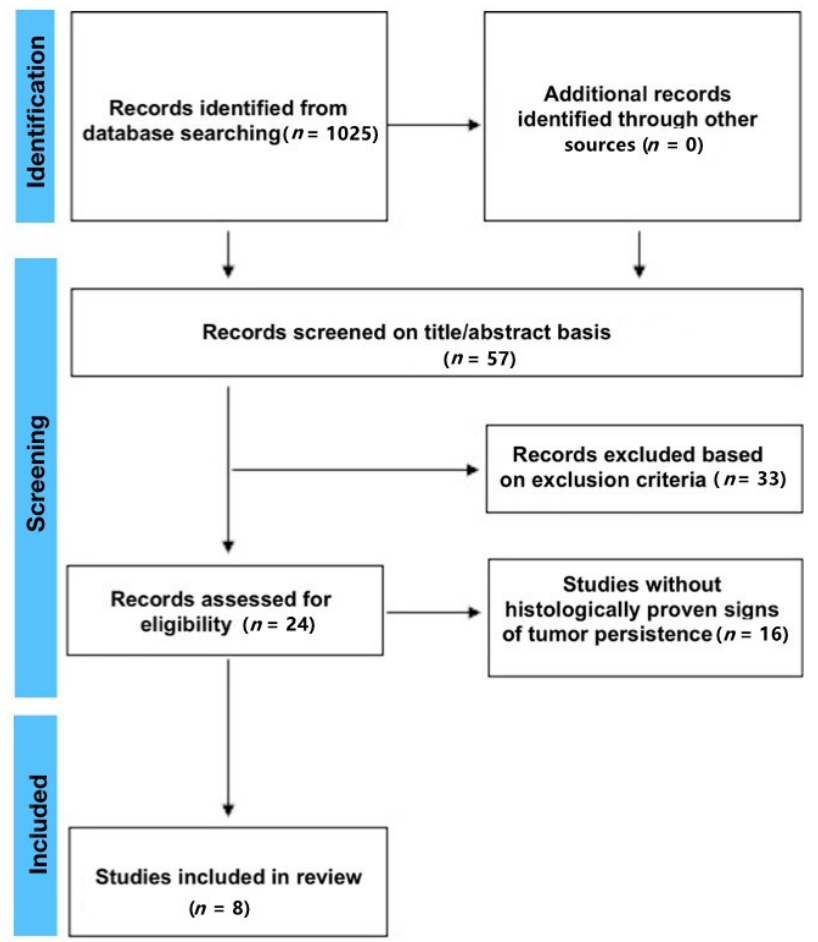
Figure 1. Literature flow diagram for the search and study